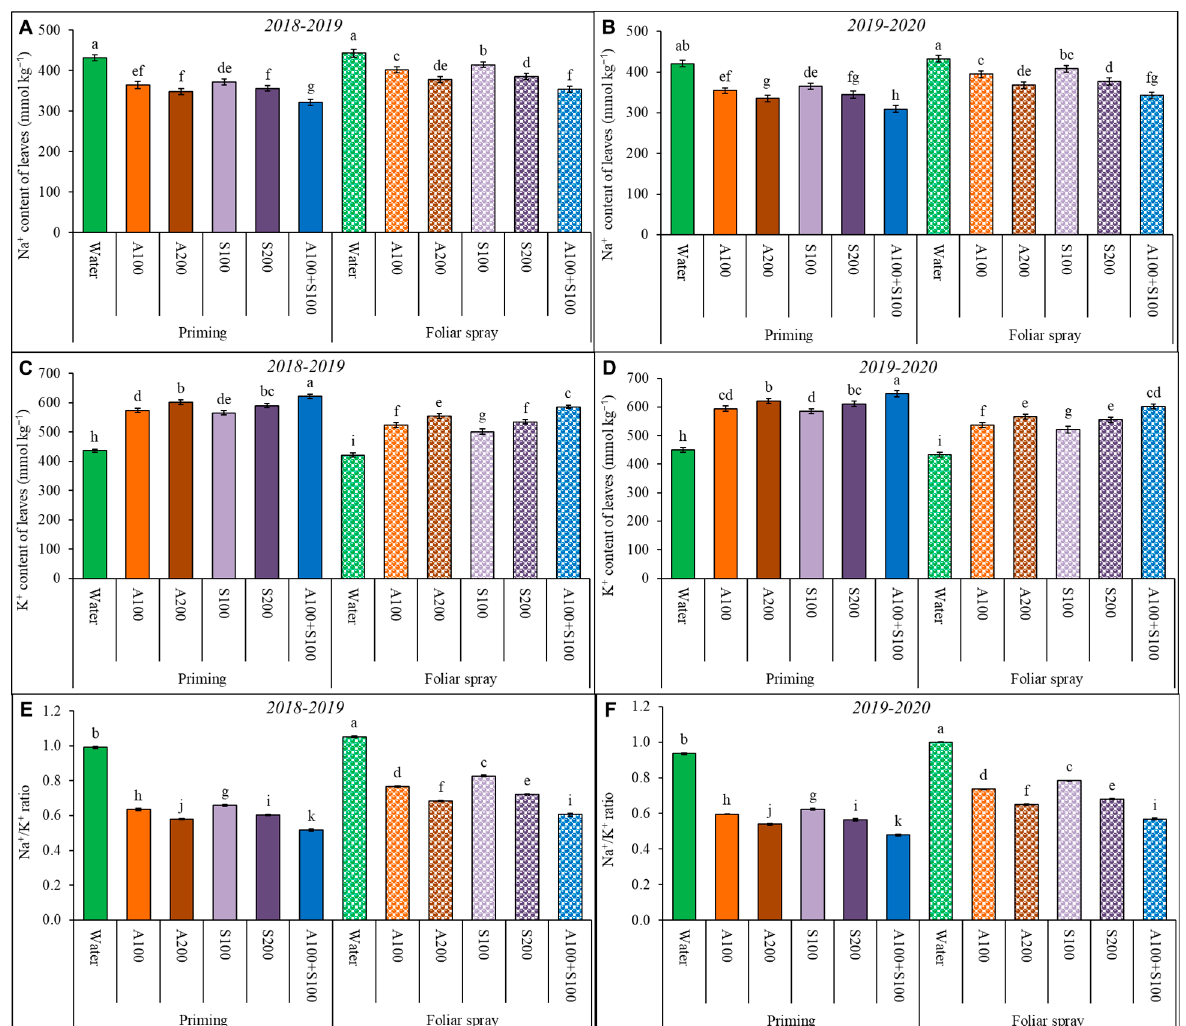
Figure 7. Effect of antioxidant AA and SA as a foliar spray and priming on sodium content ( A , B ); potassium content ( C , D ); and Na + /K + ratio ( E , F ) of wheat leaves in the two winter seasons 2018/2019 and 2019/2020. Data are mean ± standard error ( n = 4). Letters represent significant differences between treatments at p < 0.05 level according to the LSD test.